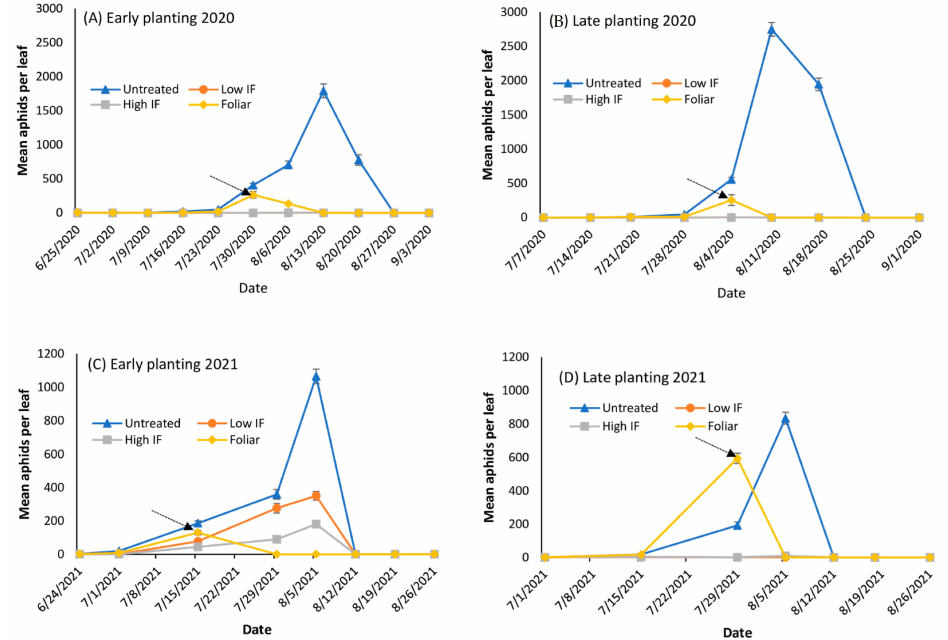
Figure 2. Mean number of Melanaphis sorghi on bottom leaves for early ( A ) and late ( B ) planting in 2020 and for early ( C ) and late ( D ) planting in 2021 on forage sorghum in Florence, SC. The arrow indicates timing of foliar insecticide application. The four insecticide treatments are: the untreated, low in-furrow (IF), high IF, and foliar applications with